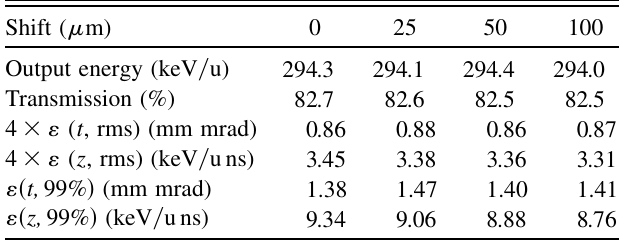
TABLE IX. Effect of global shifts of the vanes from each other with increasing distance.